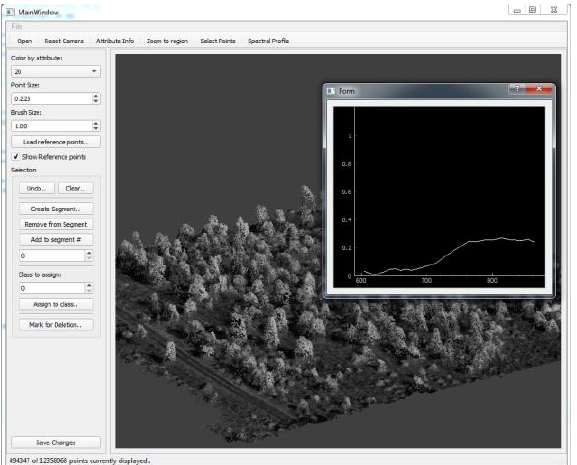
Figure 2. Screenshot of the developed HyPC visualisation